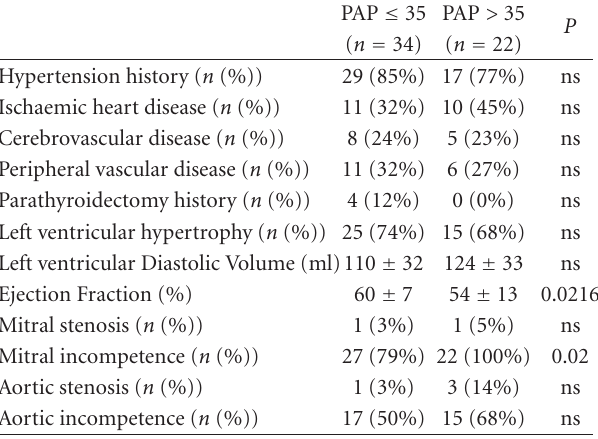
Table 3: Cardiovascular condition of patients with and without pulmonary hypertension.